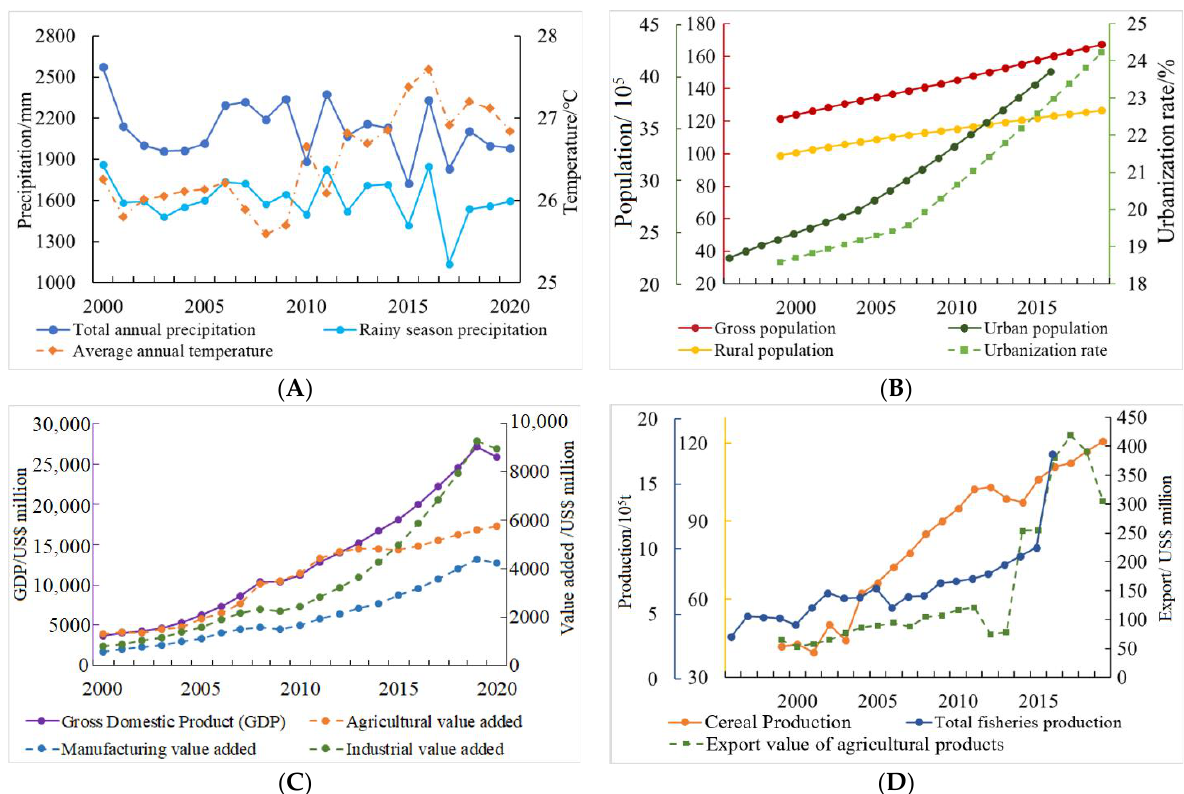
Figure 6. Development status in Cambodia from 2000 to 2020. ( A ) Climatic factors; ( B ) population factors; ( C ) economic factors; ( D ) production and export factor.